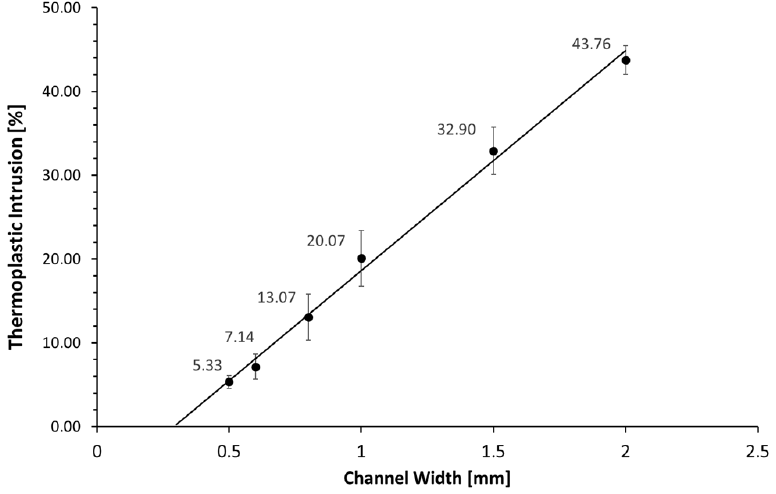
Figure 7. Thermoplastic intrusion into channel as percentage of channel width.